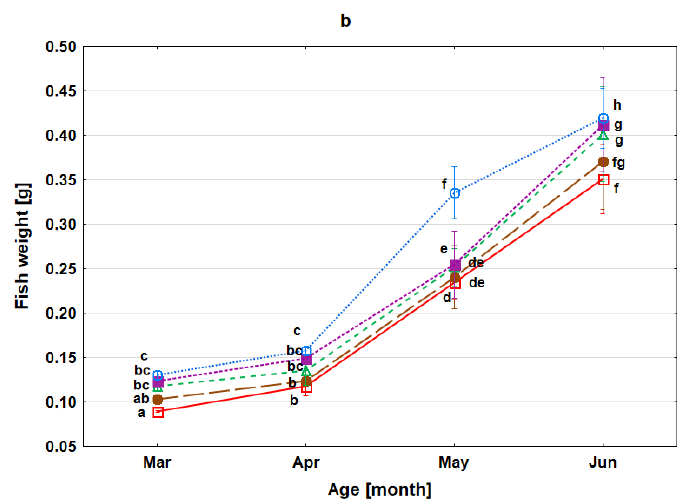
Figure 2. The Length (fork length) ( a ) and weight ( b ) of the sea trout fry ( Salmo trutta m . trutta ) developed from eggs exposed to different concentrations of inorganic selenium (SeO 2 ) in water during egg swelling 0, 1, 2, 8, 16 mg Se L − 1 . Values marked with the same letter are not significantly different from one another ( p > 0.05). Two-way ANOVAs and then Fisher tests were used for the post-hoc comparison. □ – 0 Se (red); ● – 1 Se (brown); ∆ – 2 Se (green); ■ – 8 Se (violet); ○ – 16 Se (blue) .